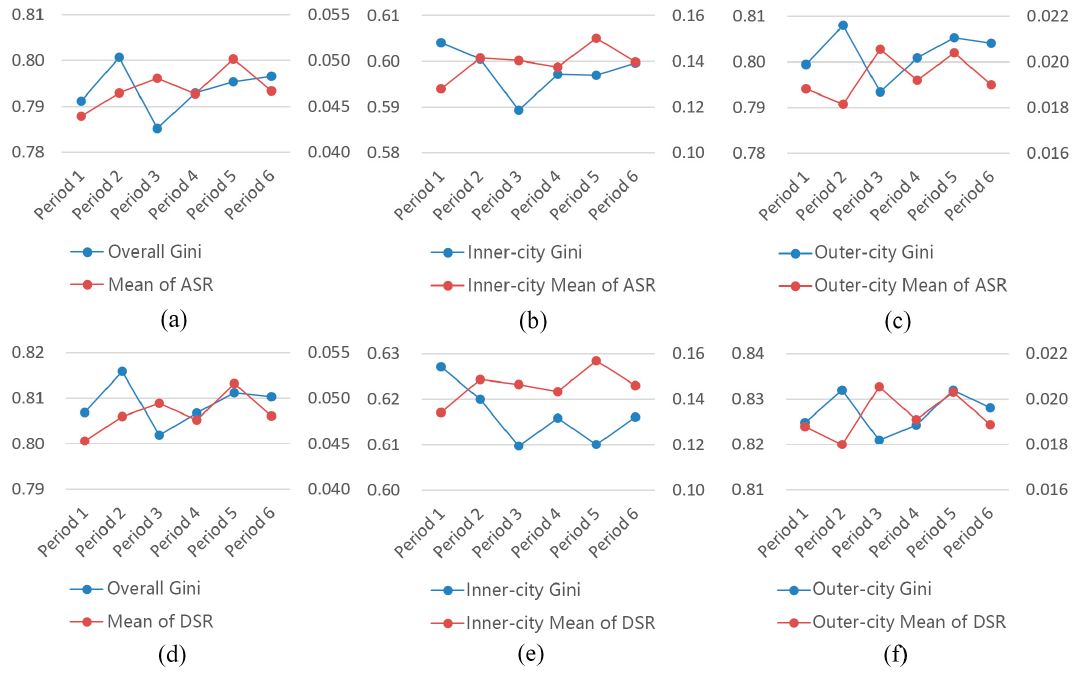
Table 5. The Theil index and its decomposition of the service rate on weekdays. ASR DSR Period Between-Group Within-Group Inequality Inequality